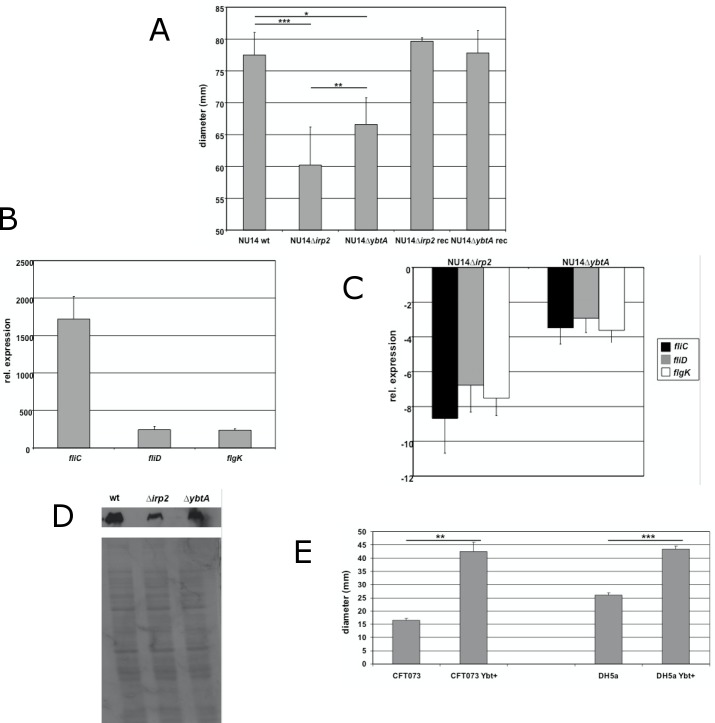
In vitro characterizations of the contribution of the HPI to motility in UPEC strain NU14.(A) Deletions of both irp2 and ybtA resulted in the reduction of the motility diameter on LB soft agar plates (0.3%). Motility was restored in complemented strains. qPCR for flagellar genes during motility in wild type strain NU14 (B) and in HPI mutants (C). Data were normalized to 16S rRNA. Bacteria rotating in LB at 37°C were used as the calibrator for (B) and wild type strain NU14 during motility served as the calibrator for (C). (D) Detection of flagellin expression using H7 antiserum. Lane 1, NU14 wild type; lane 2, NU14 Δirp2; lane 3, NU14 ΔybtA. (E) The impact of yersiniabactin production on motility in yersiniabactin-negative strains. CFT073 ybt+ and DH5α ybt+ displayed increased motility compared to the respective wild type strains. All experiments were performed in triplicates and repeated at least three times. Error bars represent standard deviations. *p<0.05, **p<0.01, ***p<0.001.